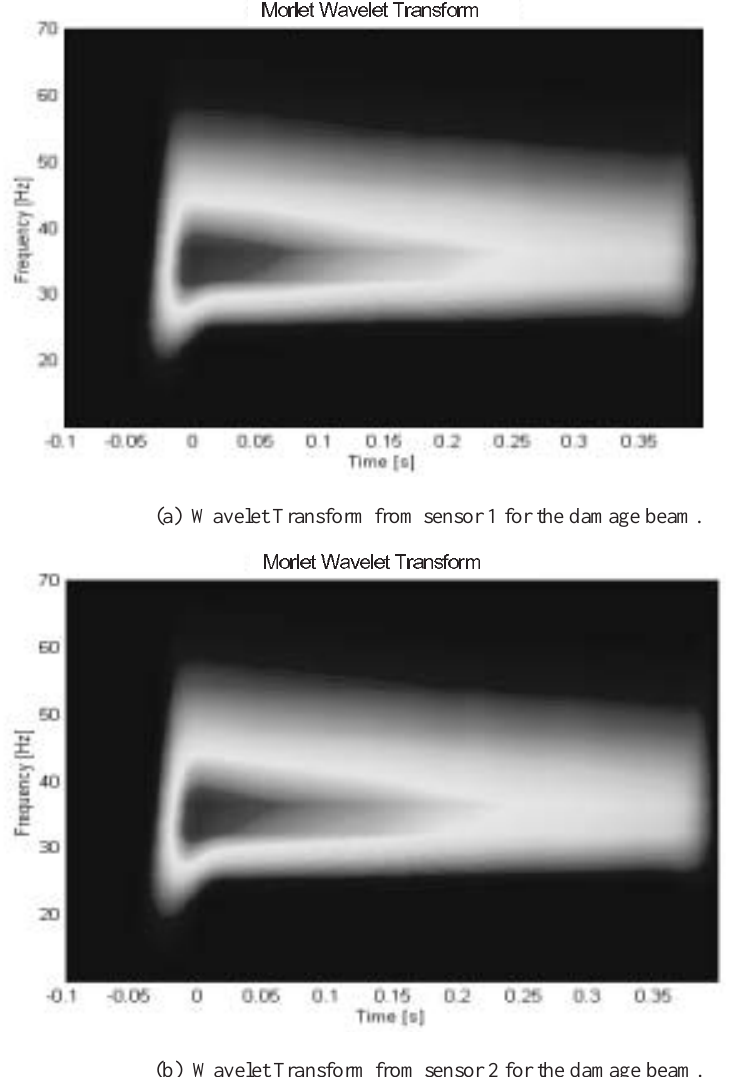
Fig. 9. Wavelet Transform of the transient response of the damage